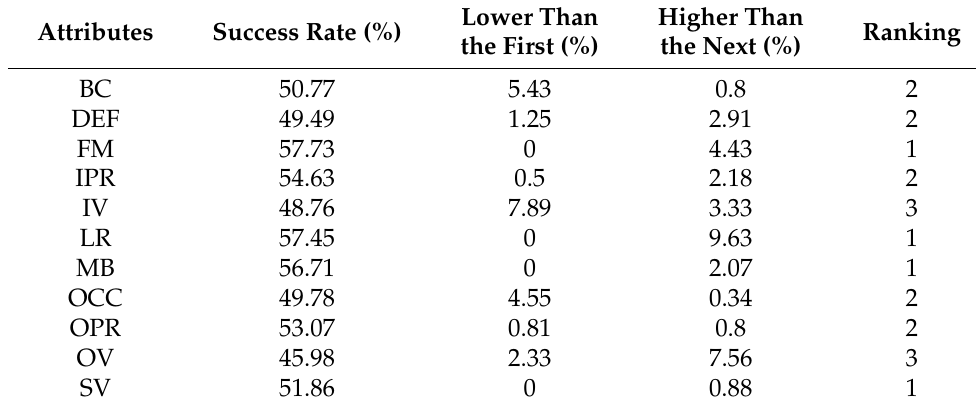
Table 4. Attribute-based success evaluation of the proposed trackers.